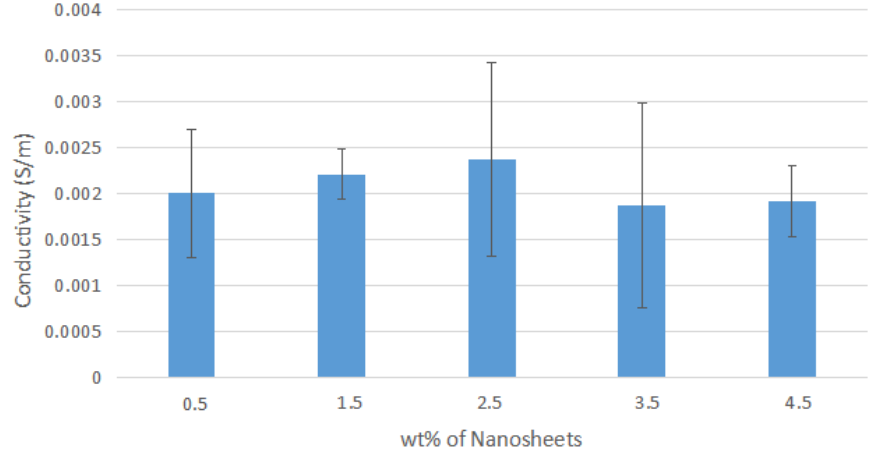
Figure A2. Average Conductivity of Nylon 610 Nanocomposites with Nanosheets Treated at 175 °C and − 0.1 MPa.